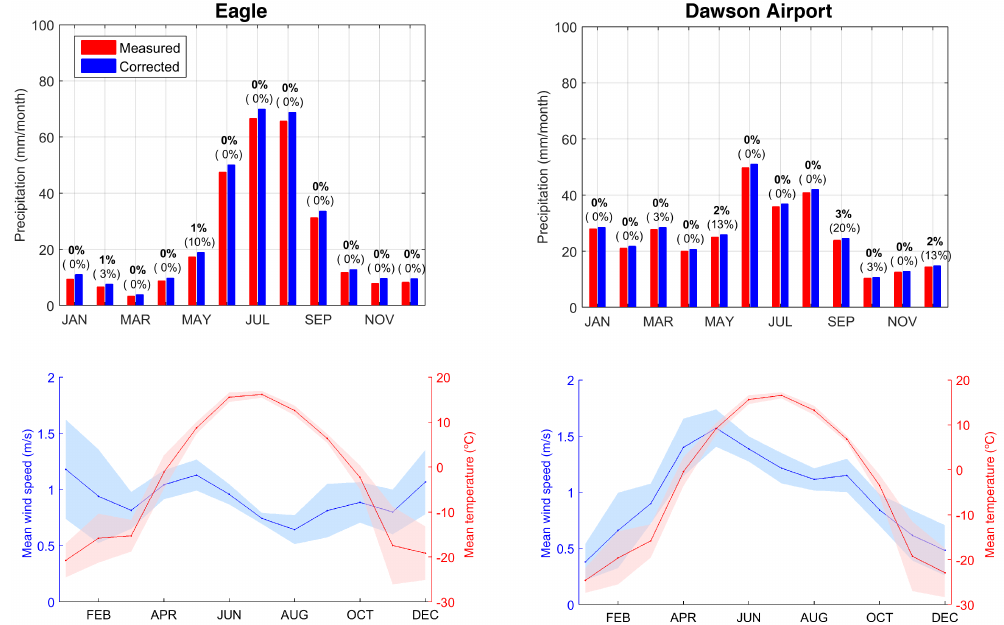
Figure 5. Monthly mean precipitation at two stations during 2006–2013 (upper panels) and corresponding monthly mean wind speed and air temperature (bottom panels). Shadows represent the 95% confidence interval for the temperature and wind speed. The percentages above the bars represent the missing data for the corresponding time step. The bold percentage is the monthly mean, and the one in the parentheses is the maximum missing value in the study